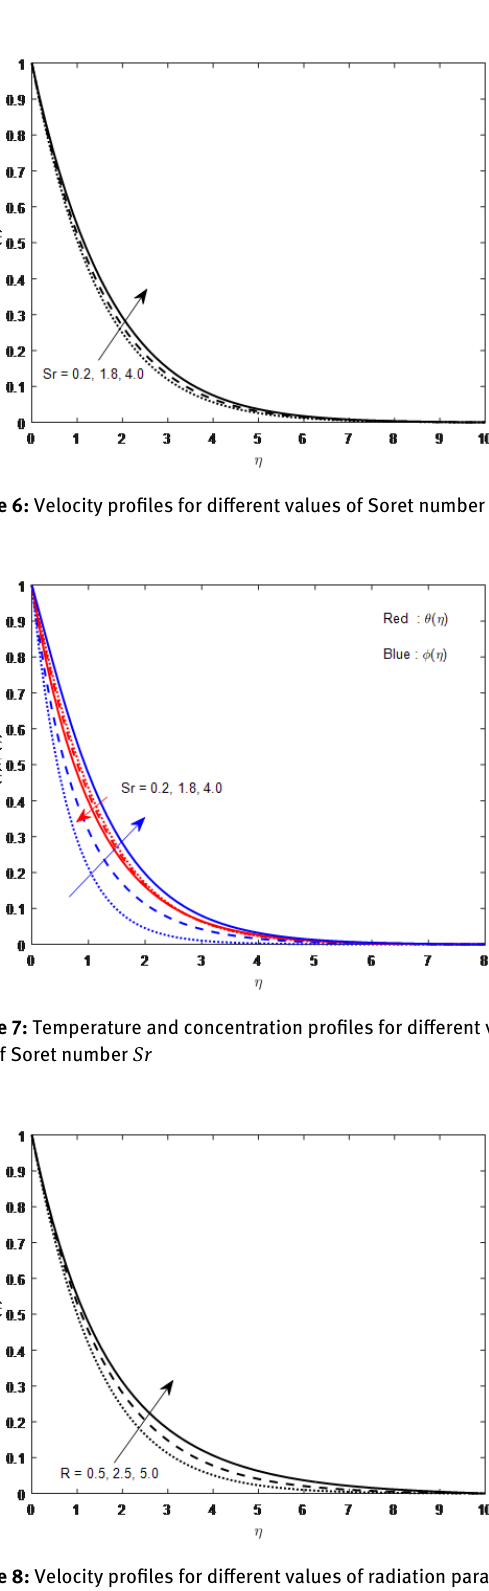
Figure 5: Temperature and concentration profiles for different val- ues of Dufour number Du